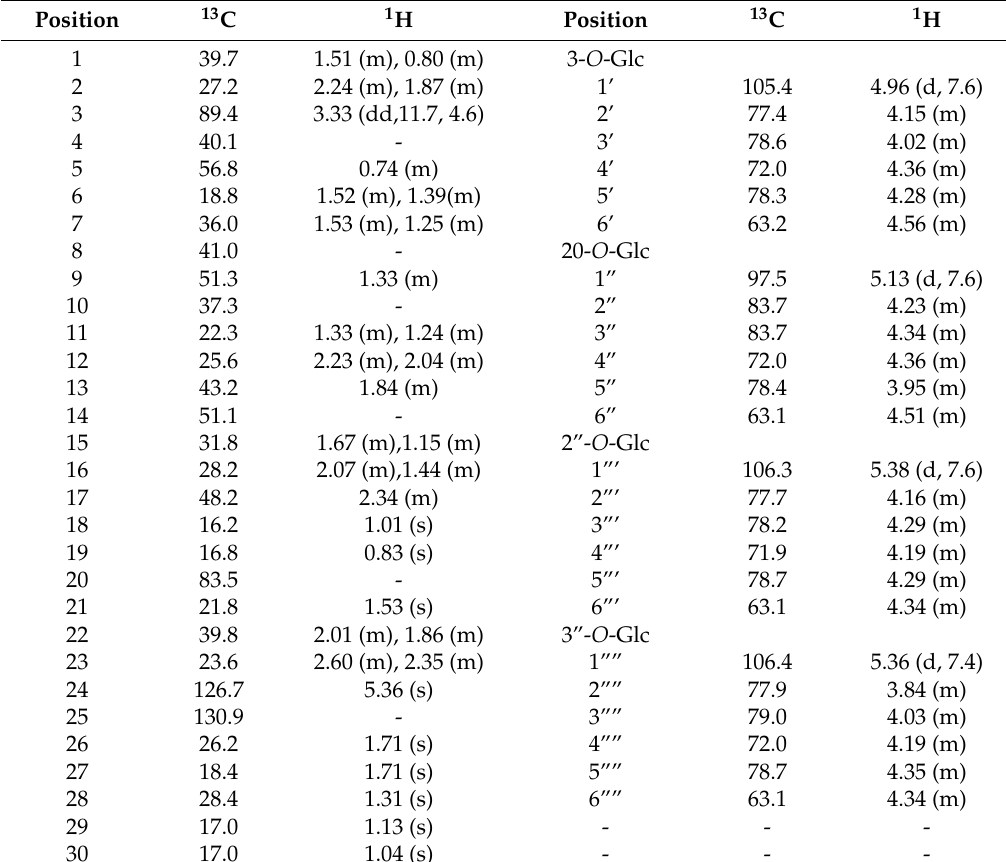
Table 3. 1 H-NMR and 13 C-NMR spectral data of compound 7 (600 MHz and 150 MHz, pyridine- d 5 , δ in ppm, J in